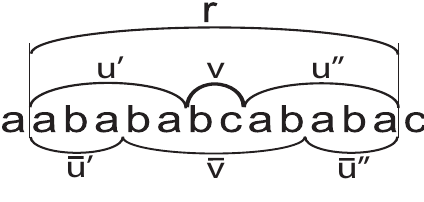
Figure 1. Principal and nonprincipal